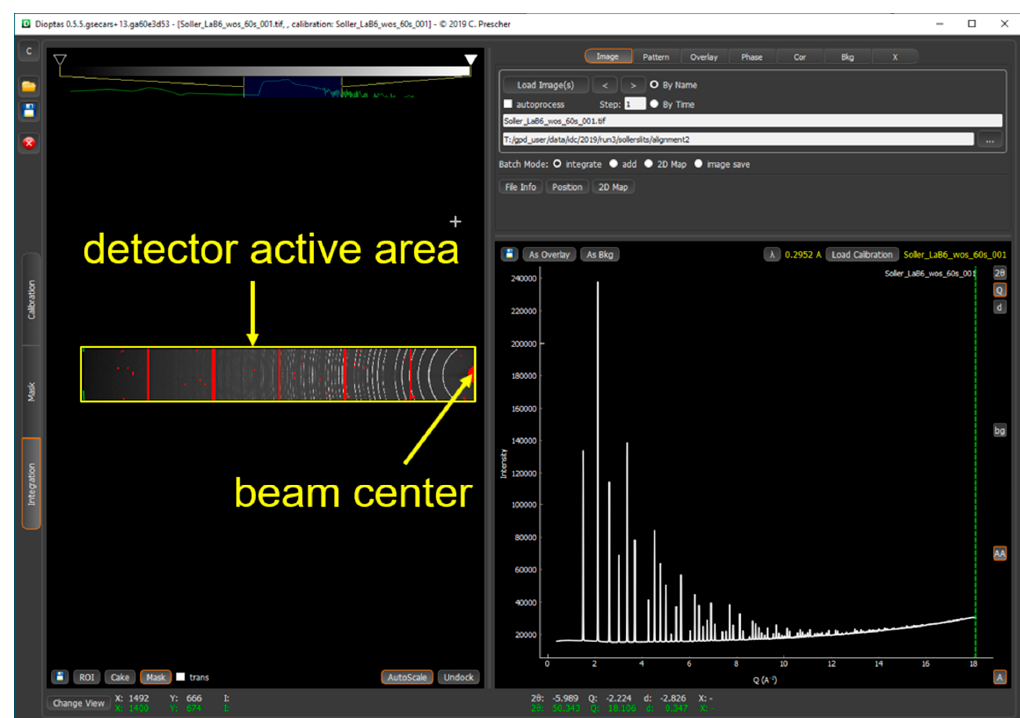
Figure 6. A Dioptas window showing the 2D X-ray diffraction image of the lanthanum hexaboride (LaB 6 ) powder (NIST 660C) collected using the Pilatus3 X CdTe 300K-W detector (left panel). We can work with image files that only recorded a portion of the diffracted powder rings. The right panel is the integrated diffraction pattern. LaB 6 powder is filled in a 0.5 mm diameter amorphous silica capillary and mounted in the horizontal plane oriented perpendicular to the incident beam. LaB 6 serves as the line position standard for calibrating detector parameters.